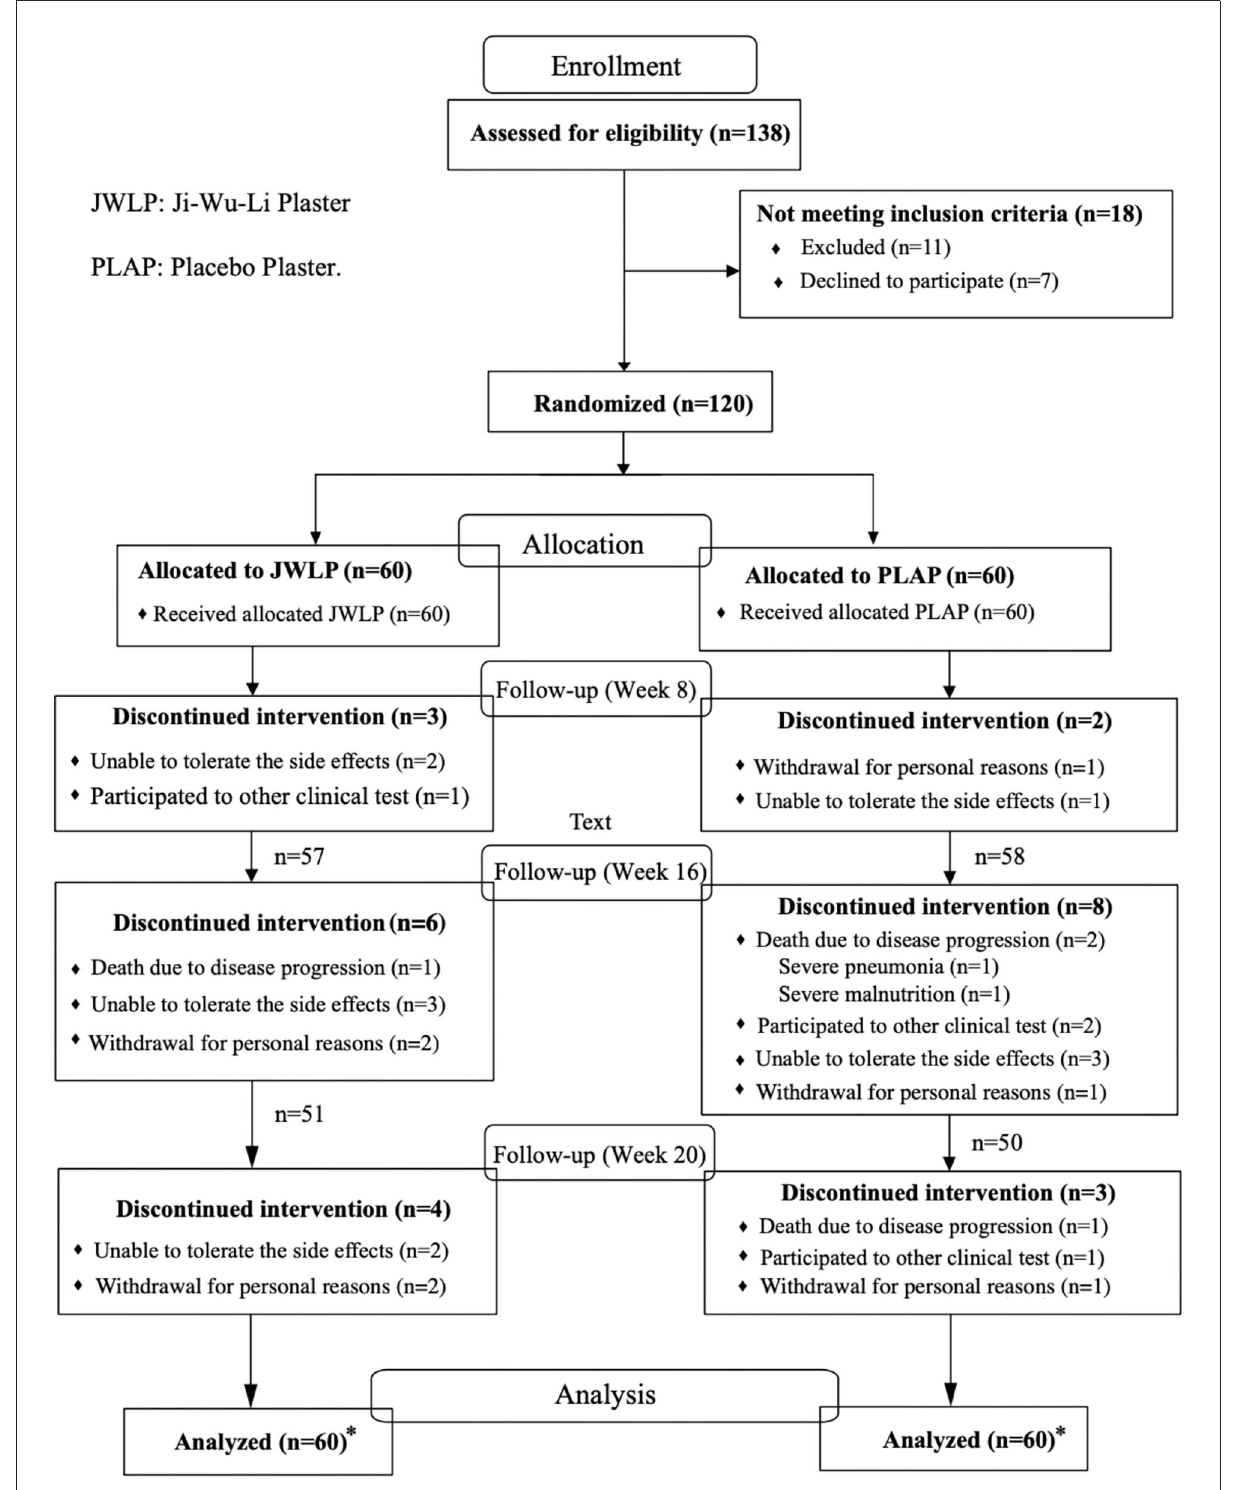
FIGURE3 CONSORT flow diagram of the ALS-CHEPAL trial. *Intent-to-treat principle, all randomized participants were